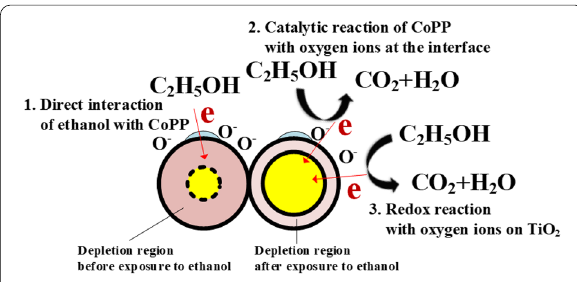
Fig. 4 Detailed ethanol-sensing mechanism of CoPP-functionalized TiO 2